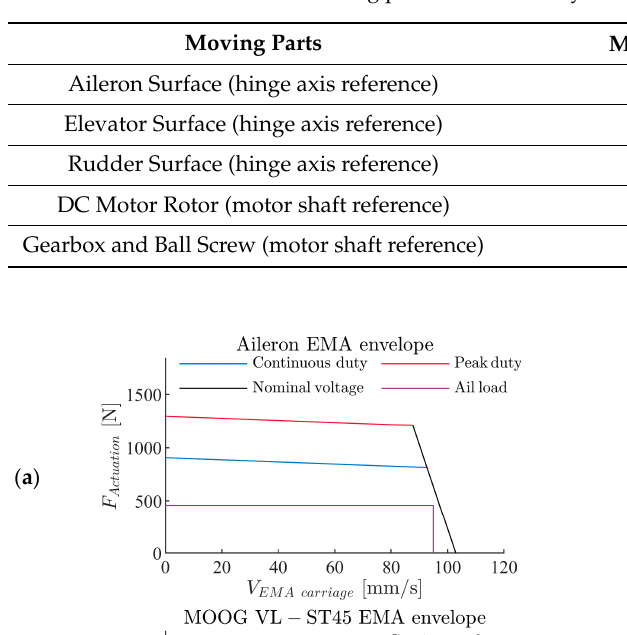
Table 3. Moment of inertia of moving parts of the EMA system.